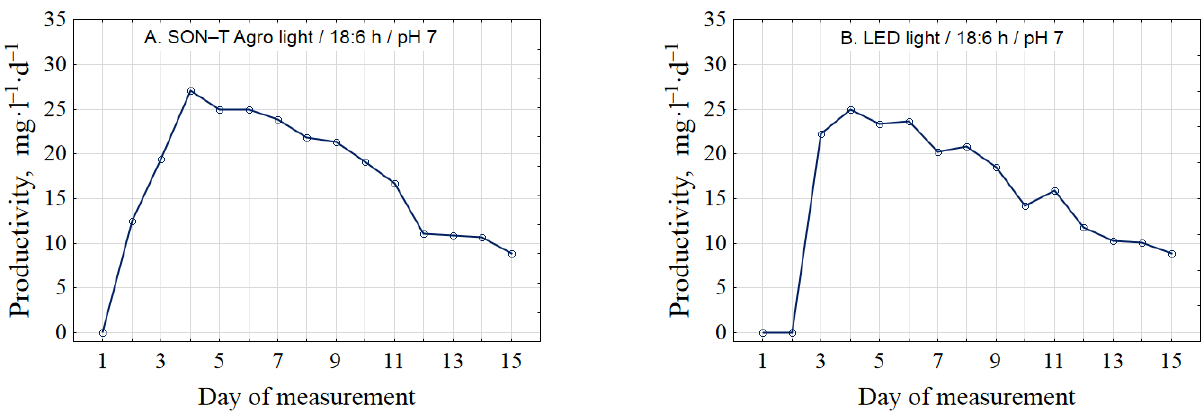
Figure 2. Dynamics of the growth of microalgae biomass in SON-T Agro light ( A ) and light-emitting diode (LED) light ( B ) during different light:dark cycle. Figure 3. Biomass productivity under optimal culture conditions in SON-T Agro light ( A ) and LED light ( B ).